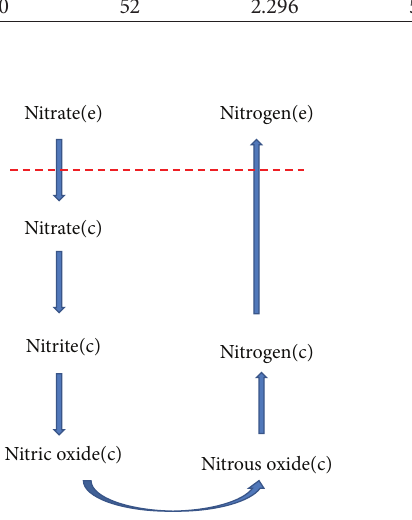
Figure 4: Denitrification pathway. Metabolites like water, proton, ferricytochrome 𝑐 , ubiquinol, and ubiquinone are excluded for clarity. Dashed line shows the system